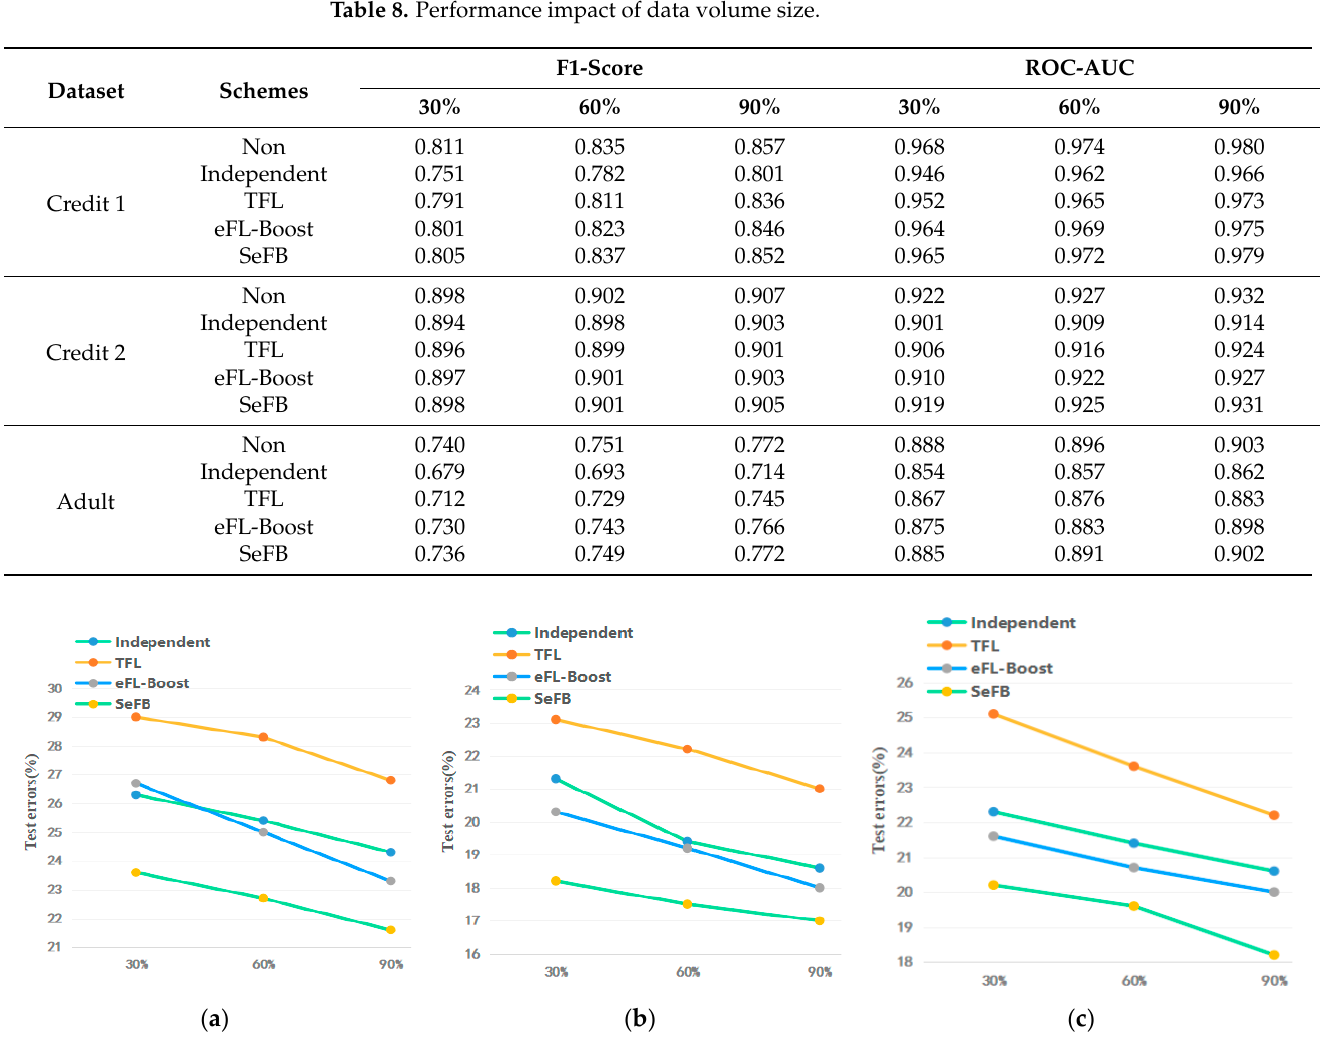
Figure 6. Impact of data volume size on Test Errors. ( a ) Credit 1 dataset, ( b ) Credit 2 dataset, ( c ) Adult dataset.